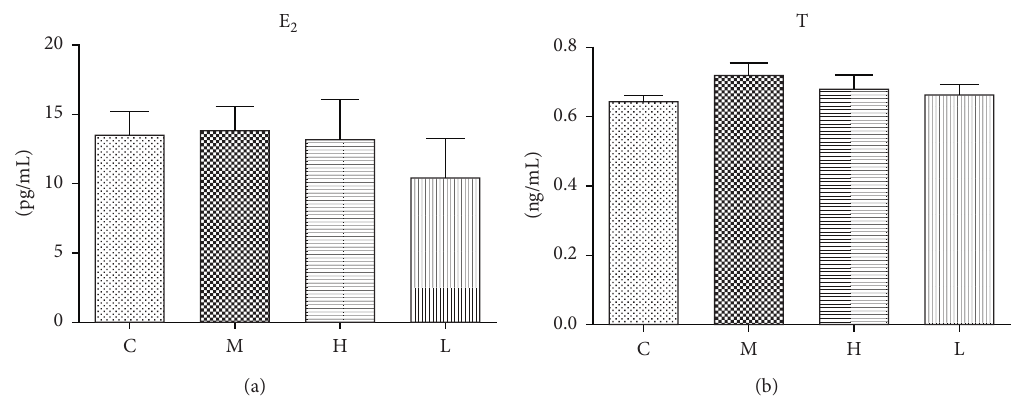
Figure 3: Serum E 2 (a) and T (b) levels among rats in different groups.